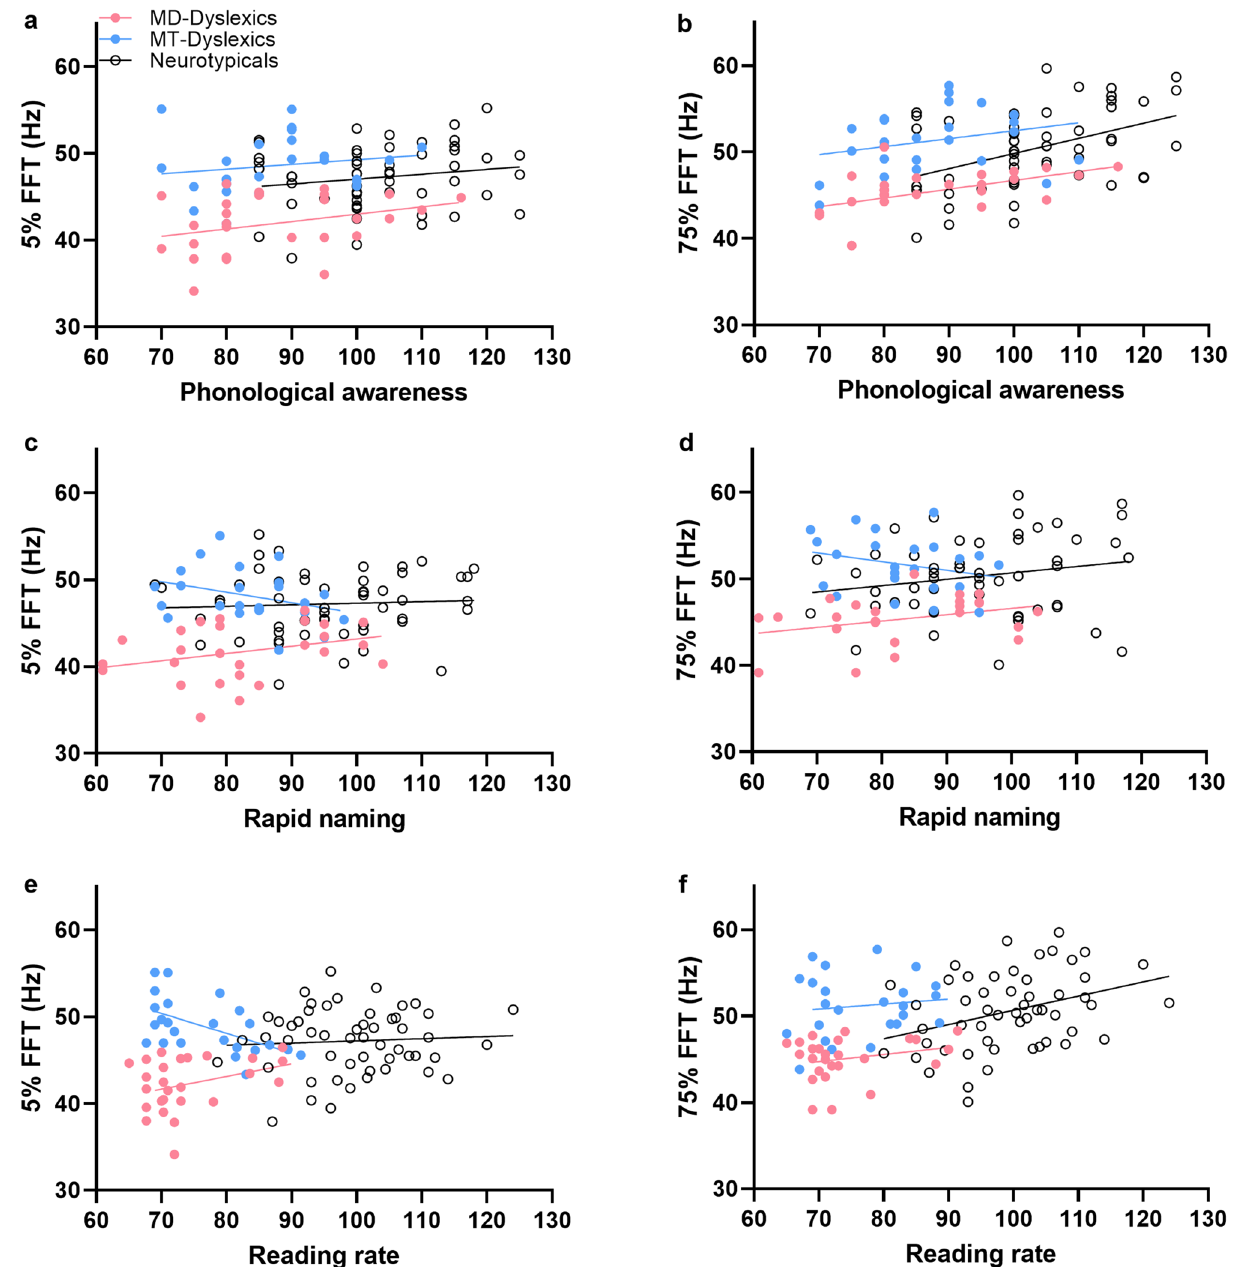
Figure 2. Correlations between Flicker Fusion Thresholds (FFTs) and reading measures; Low Contrast (5%) FFTs and ( a ) Phonological awareness; ( c ) Rapid Naming; ( d ) Reading Rate; and High Contrast (75%) FFTs with ( b ) Phonological awareness; ( d ) Rapid naming; ( f ) Reading